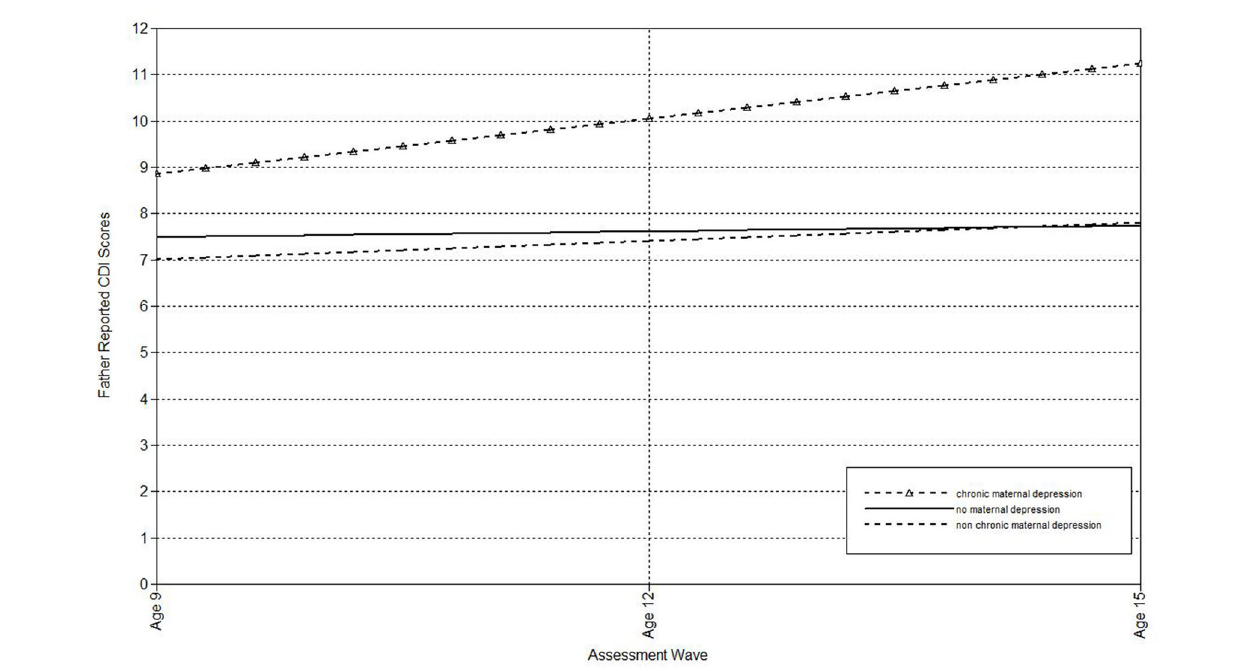
FIGURE 4 | Effect of chronic maternal depression (life-course perspective) on the slope of father-reported CDI scores in offspring.